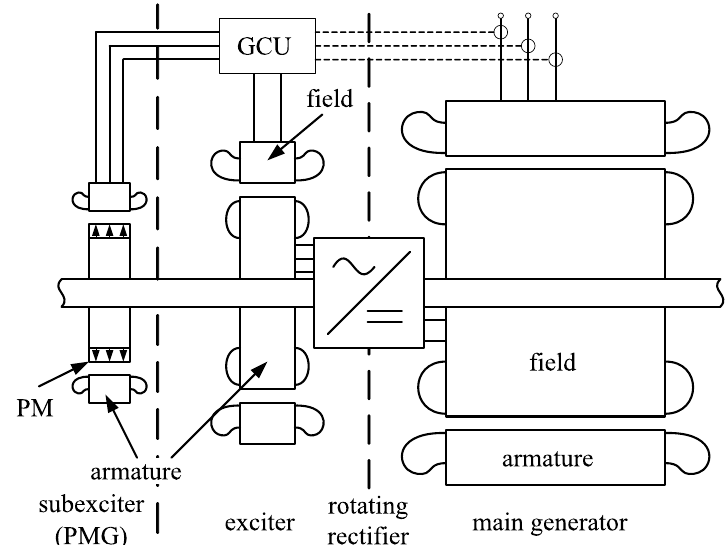
Figure 1. The brushless synchronous generator—based on a three-stage electrical machine topology: the subexciter—permanent magnet generator (PMG); the brushless exciter—synchronous machine with stationary field winding, rotating armature winding and rotating diode rectifier; the main generator—synchronous machine with rotating field winding; GCU—generator control